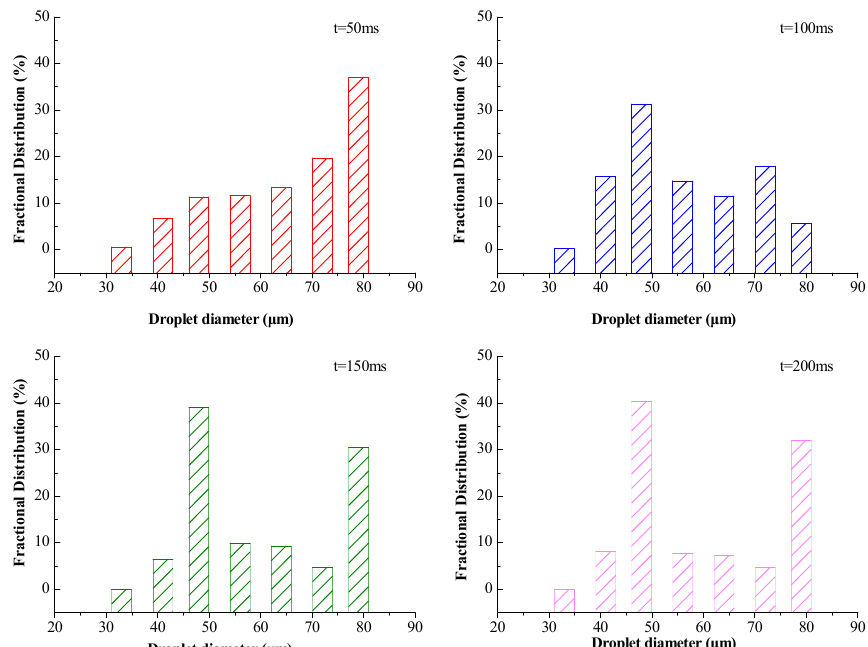
Figure 8. Droplet size distribution at different time when the air inflow is 12 g/s, the oil inflow is 15 g/s, and the initial oil droplet diameter is 28 μm.